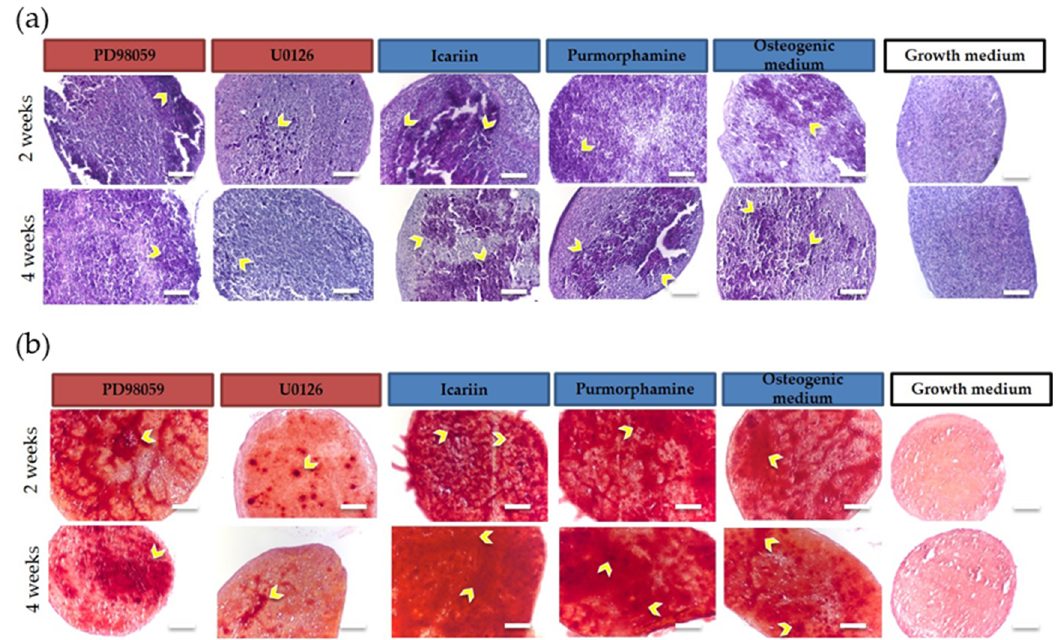
Figure 1. Images of ( a ) H&E and ( b ) Alizarin Red staining of 3D bioprinted constructs (n = 3 per medium condition) at two weeks and four weeks in culture. Cells showed non-uniform calcium deposition, displaying zones of accumulation (dark purple/red; indicated by yellow arrows) indicative of osteogenic differentiation (10× magnification, scale bar = 500 μm).